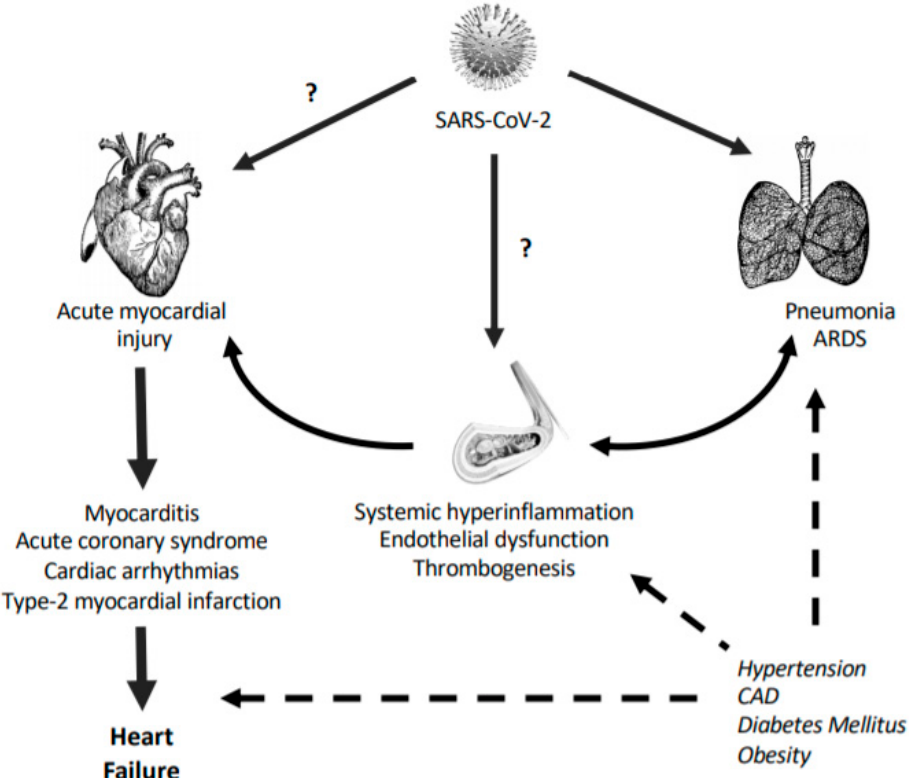
Figure 1. COVID-19 and the cardiovascular (CV) system. The initial step of disease begins with SARS-CoV-2 infection in the upper respiratory system, which leads to fever or cough as the main symptomatology. Then, in some cases, viral infection leads to lung injury characterized by dyspnea, lung inflammation, and pneumonia, with or without associated hypoxia. Later on, if the infection progress, the acute respiratory distress syndrome (ARDS) and extrapulmonary manifestations can appear. Systemic and local hyperinflammation may provoke endothelial dysfunction, vascular permeability, thrombogenesis, and altogether, acute cardiac injury characterized by arrhythmias, acute coronary syndrome, or type-2 myocardial infarction. Also, in COVID-19 subjects, diverse underlaying comorbidities, such as hypertension, coronary artery disease (CAD), and obesity, could accelerate these events. In addition, CV cells may be directly infected by viral particles, reinforcing myocarditis and vasculitis processes. ARDS and CAD stand for acute respiratory distress syndrome and coronary artery disease,